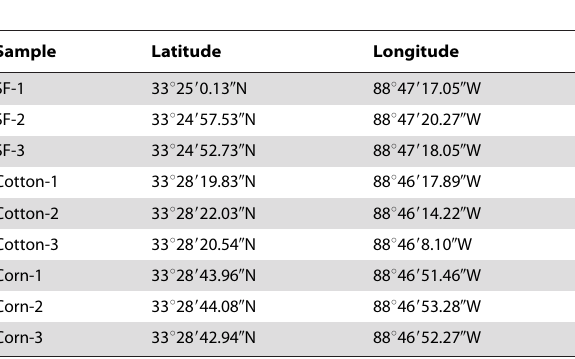
Table 1. GPS coordinates of the three SF, Cotton and Corn sites.